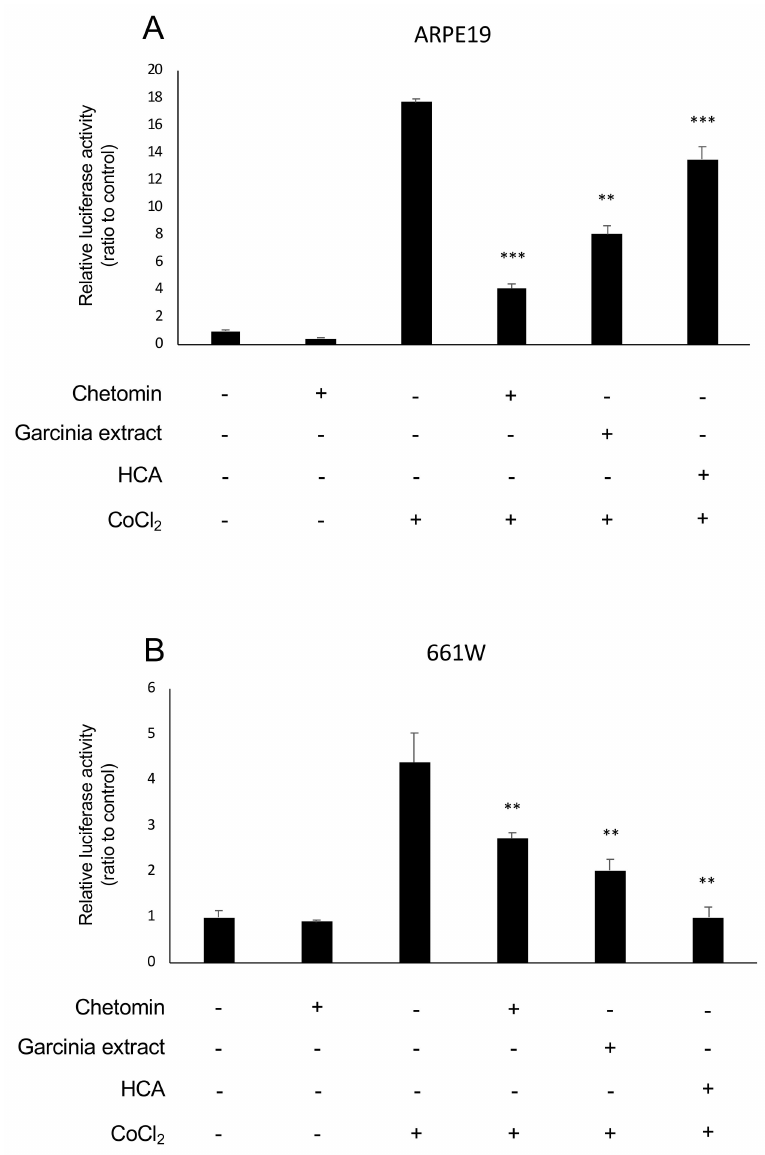
Figure 1. Garcinia cambogia extract (Garcinia extract) and hydroxycitric acid (HCA) suppressed hypoxia-inducible factors (HIF) activation in vitro. ( A ) Administration of Garcinia extract and HCA significantly suppressed CoCl 2 -induced HIF activation in ARPE19 cells. ( B ) Administration of Garcinia extract and HCA significantly suppressed CoCl 2 -induced HIF activation in 661w cells. ** p < 0.01, *** p < 0.001 compared with CoCl 2 without chetomin, Garcinia extract, and HCA, n =